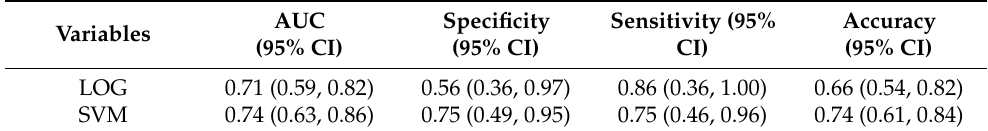
Figure 7. Feature importance of SVM. 4. Discussion In this study, 89,279 patients who underwent general anesthesia for head, neck, and maxillofacial surgeries over seven years were reviewed. Extubation failure occurred in 77 patients. Clinical data obtained from case control studies were used to introduce six machine-learning methods: RF, KNN, LOG, SVM, XGB, and GBM. Finally, two optimal machine-learning models, LOG and SVM, were used to establish a multivariate predic-